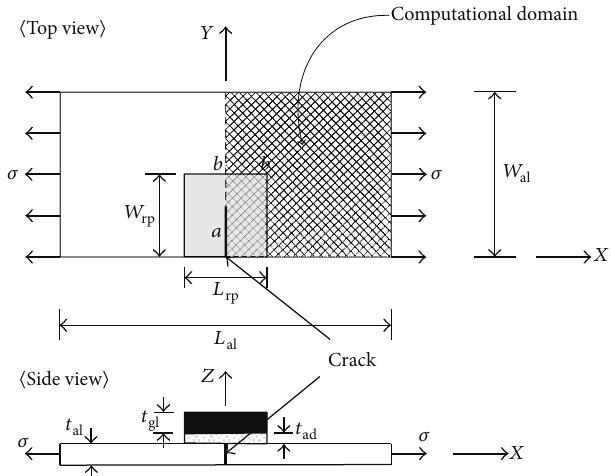
Figure 11: Single-edge-cracked plate with one-sided composite patch repair.